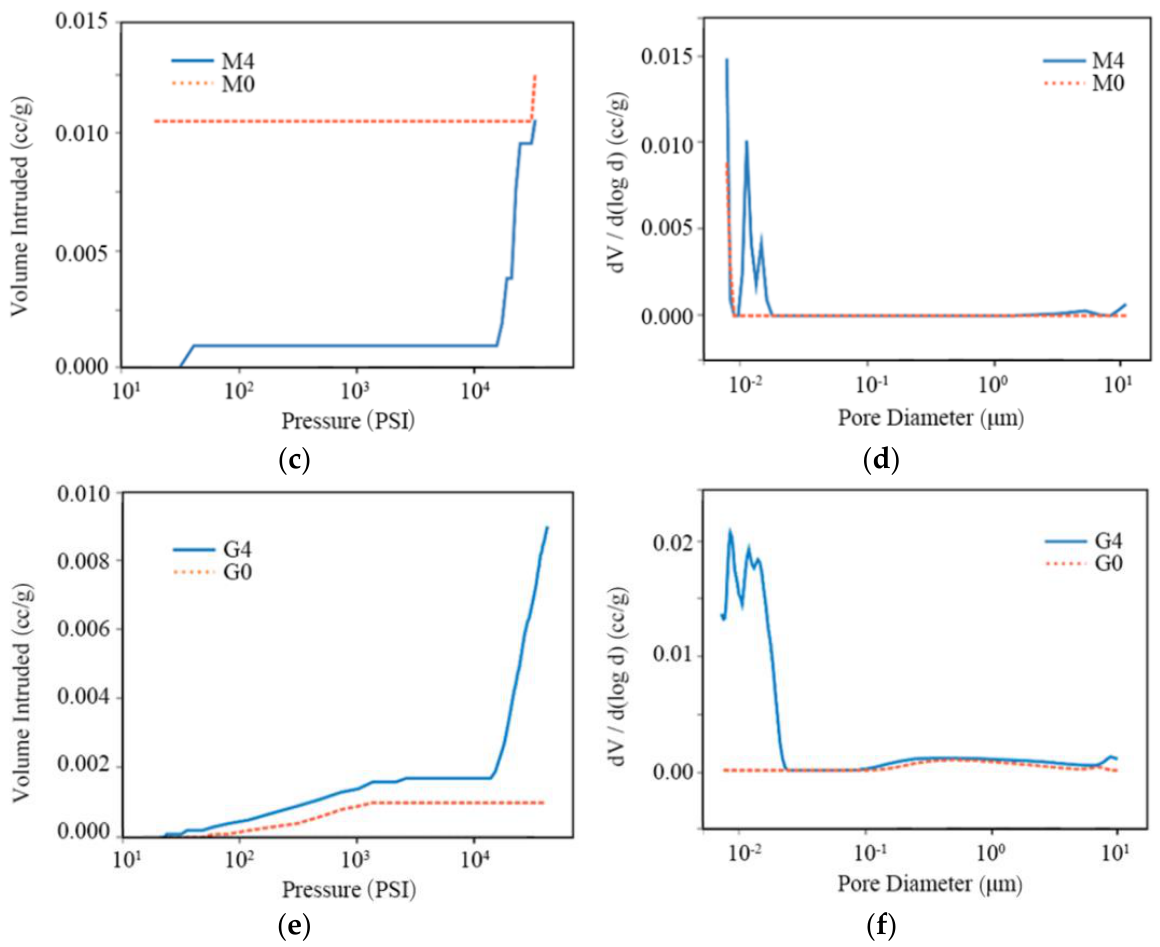
Figure 11. Intruding mercury volume with pressure ( a , c , e ) and the first derivative of pore volume with logarithmic pore diameter ( b , d , f ), for sandstone (S), marble (M), and granite (G). Table 2. Mercury intrusion pore sizing